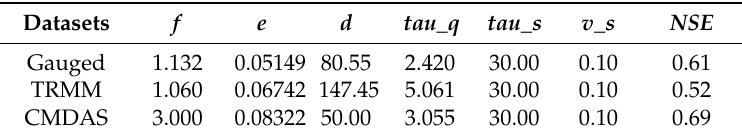
Table 5. Calibrated optimal parameters sets and daily NSE for each precipitation dataset applied to the IHACRES model (2008 to 2012).